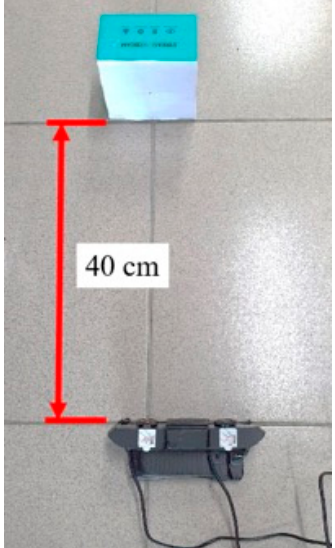
Figure 20. View of Condition 1, 40 cm far from the target to the optical center of the left lens of camera.